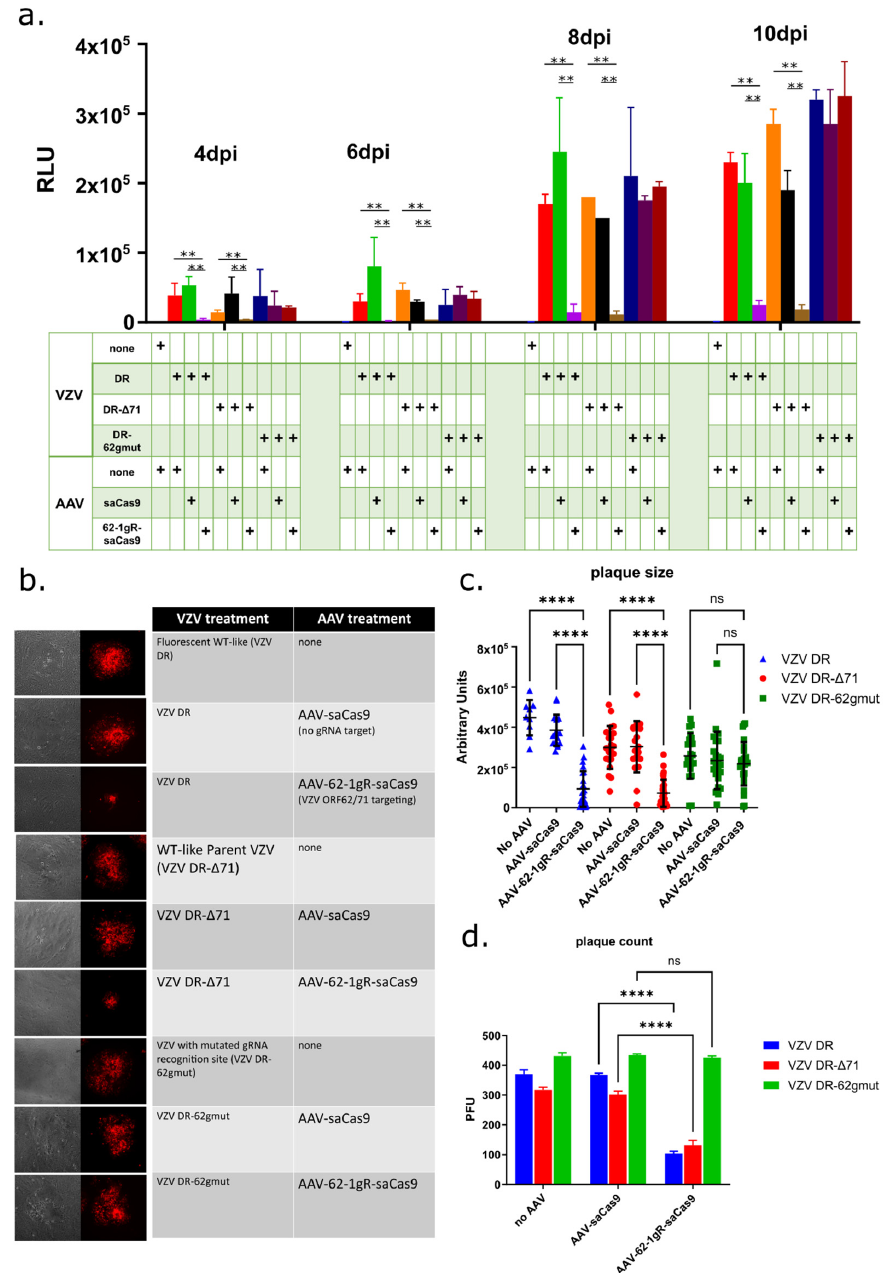
Figure 3. AAV-62-1gR-saCas9 reduces VZV productive infection in infected epithelial cells. ( a ) The